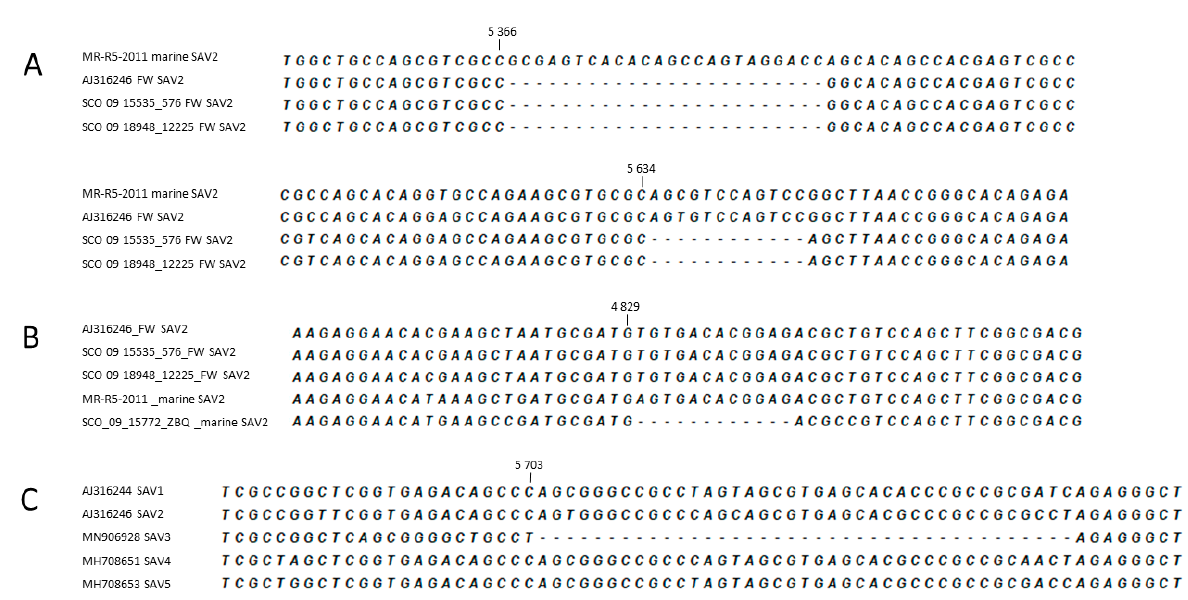
Figure 6. Graphical presentation of deletion patterns throughout the nsp3 gene of SAV2 and SAV3 strains. Positions of the deletions are relative to the FW SAV2 strain s49p (AJ316246). ( A ) The 12 nt and 24 nt deletions observed among the FW SAV2 variants, ( B ) the 12 nt deletion close to the 5 ′ end of marine SAV2 strain SCO/09/15772 ZBQ from Orkney and ( C ) the 39 nt deletion within SAV3 genotype .